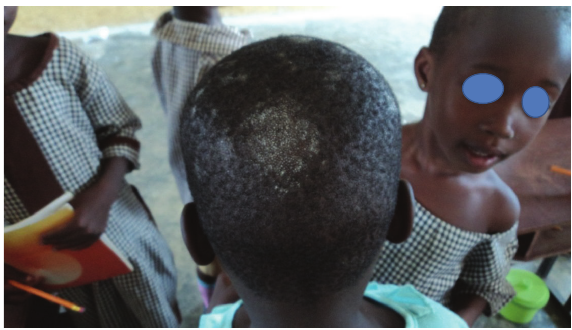
Figure 2: Tinea capitis.